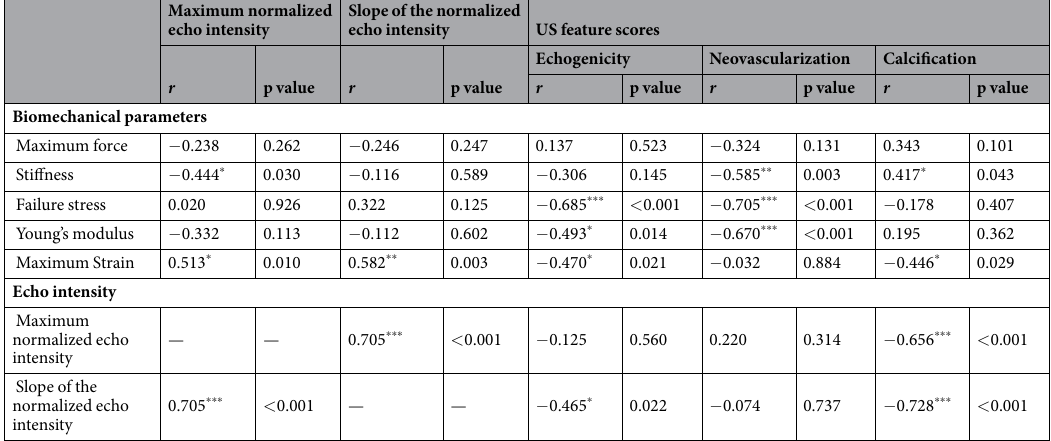
Table 2. Correlation coefficients between biomechanical parameters and characteristics of ultrasonography in the injured tendons. r is correlation coefficient; * p < 0.05, ** p < 0.01, *** p <